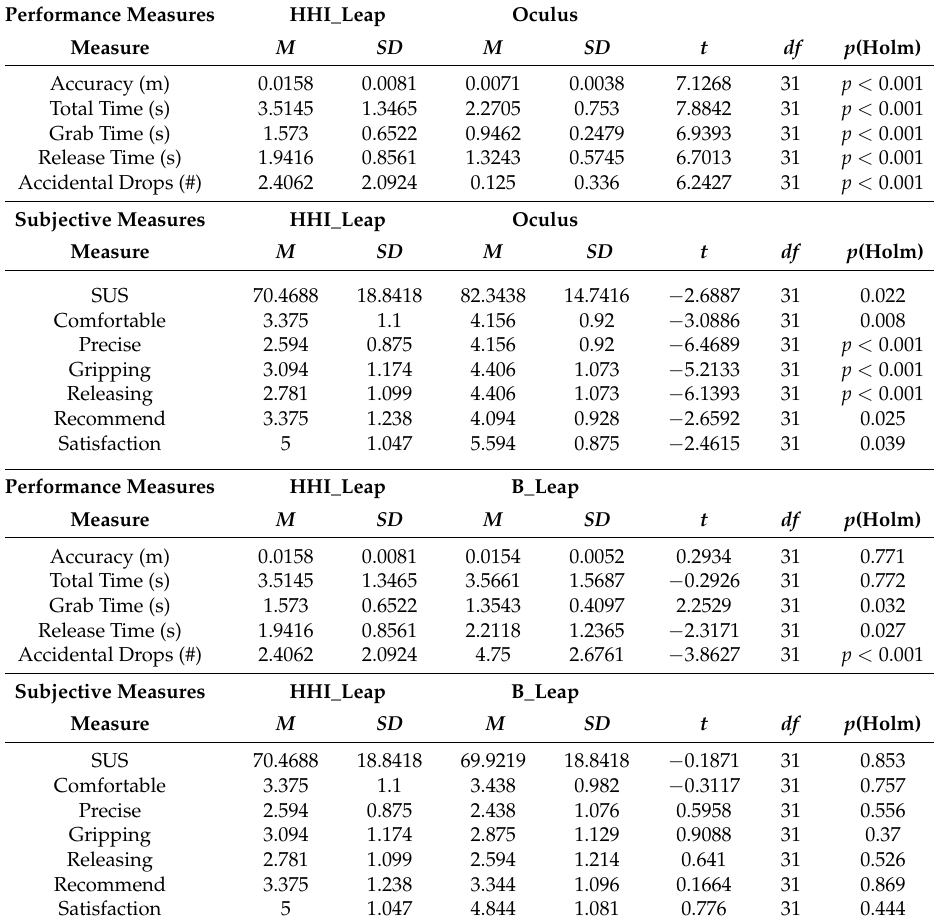
Table 2. Results of post-hoc paired t-tests, comparing performance and subjective measures for HHI_Leap and Oculus (top) as well as HHI_Leap and B_Leap (bottom). Performance Measures